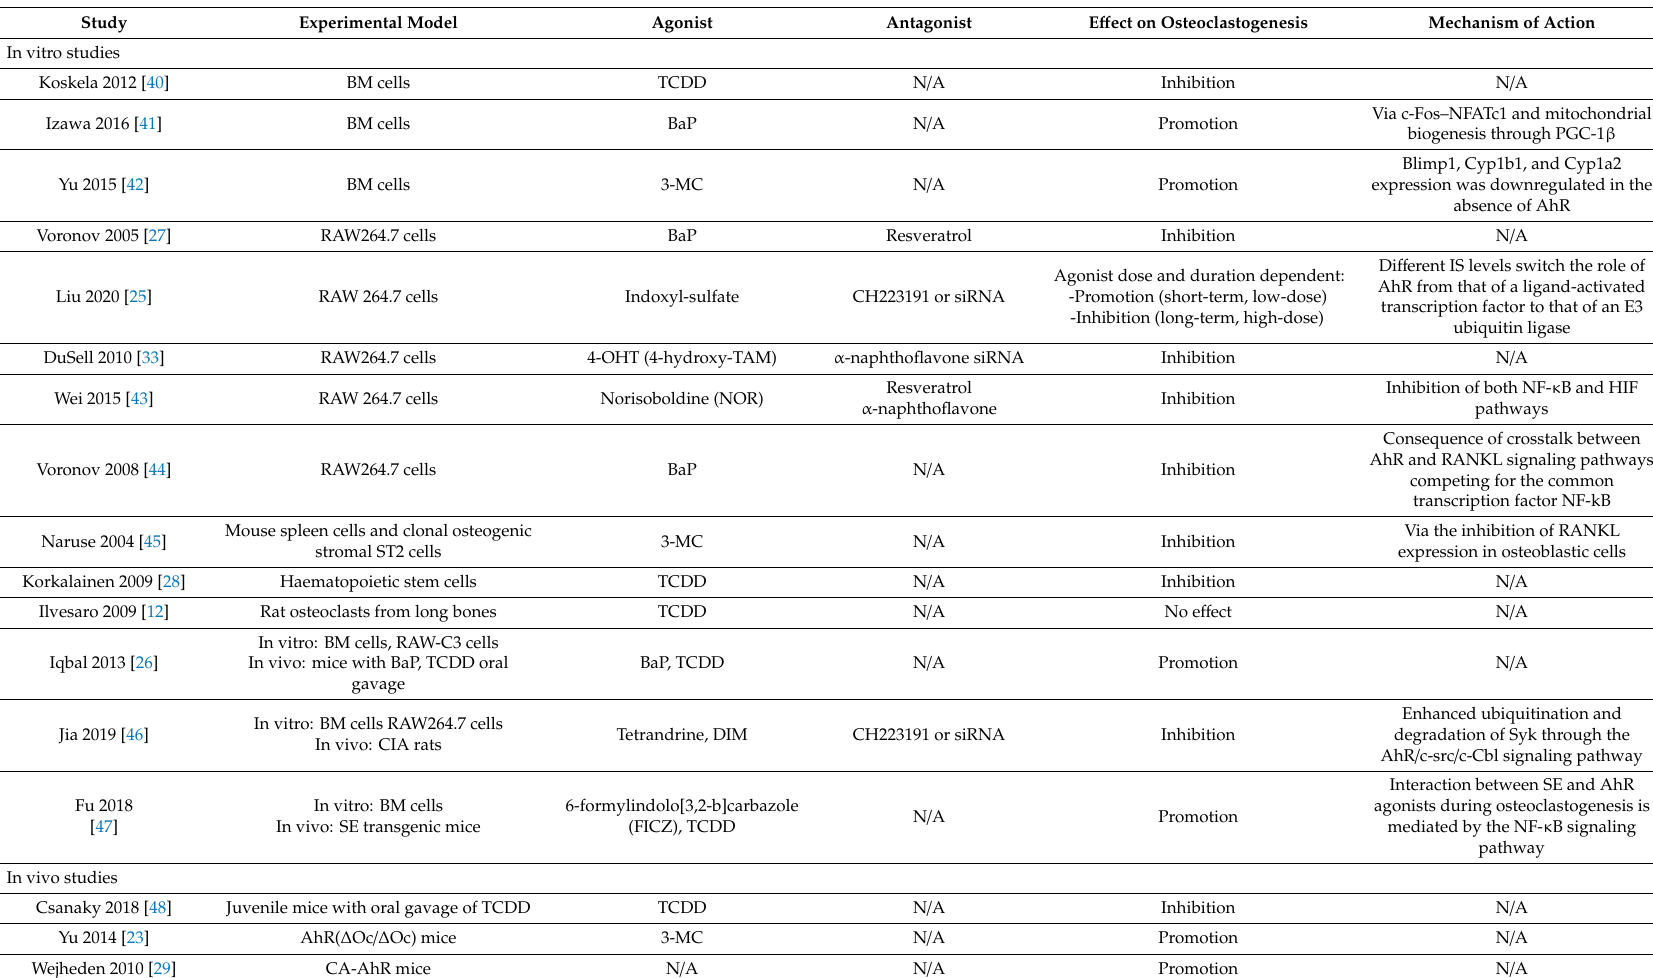
Table 1. Summary of studies on e ff ects and mechanisms of AhR ligands in vitro and in